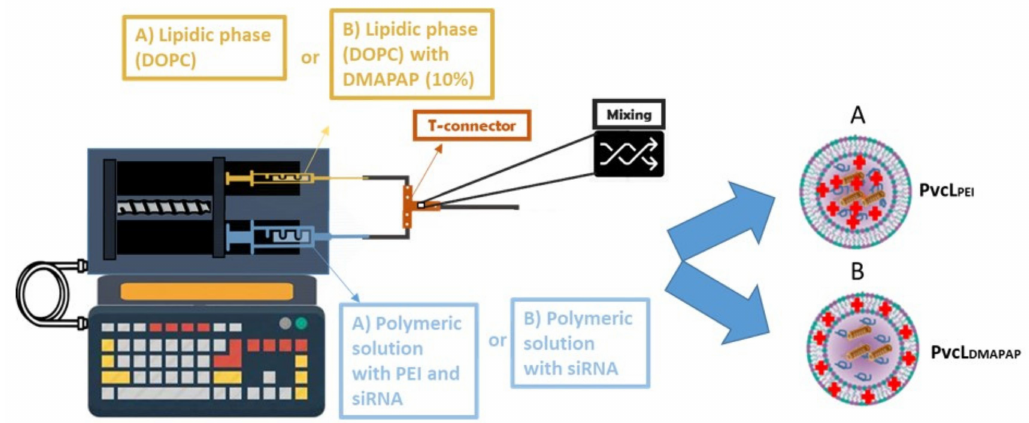
Figure 4. Graphical representation of push syringe technique for preparation of ( A ) PvcL PEI and ( B ) PvcL DMAPAP .